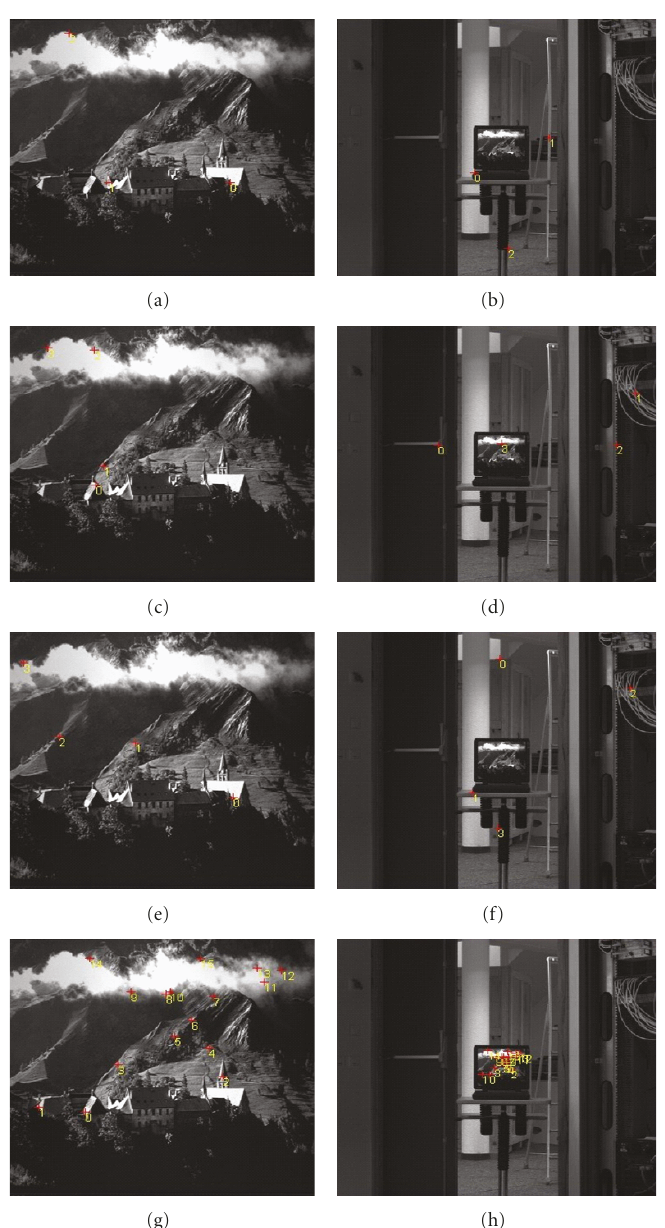
Figure 5: Group-to-group matching results for image pair Laptop with significant scale changes. (a), (c), (e), and (g) Feature points in matching results on pyramid levels 1, 2, 3, and 4 for the first image. (b), (d), (f), and (h) Corresponding feature points in matching results on pyramid level 1 for the second